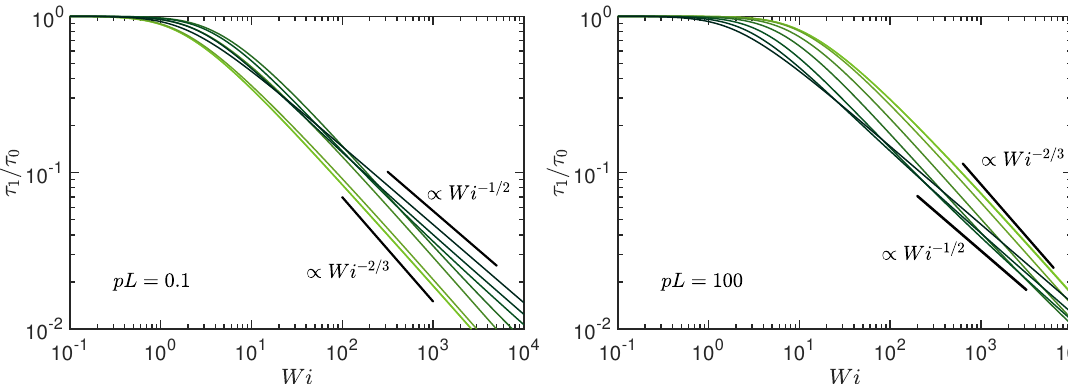
Figure 4. Longest polymer relaxation time τ 1 normalized by the longest relaxation time τ 0 of the active, non-sheared system ( Wi = 0) as function of the Weissenberg number Wi for the Péclet numbers Pe = 0, 0.6, 3, 10, 30, 10 2 ,3 × 10 2 , and ∞ (bright to dark color); ( left ) pL = 0.1 and ( right ) pL = 10 2 . The number of active sites is L / l = 10 2 and ∆ =